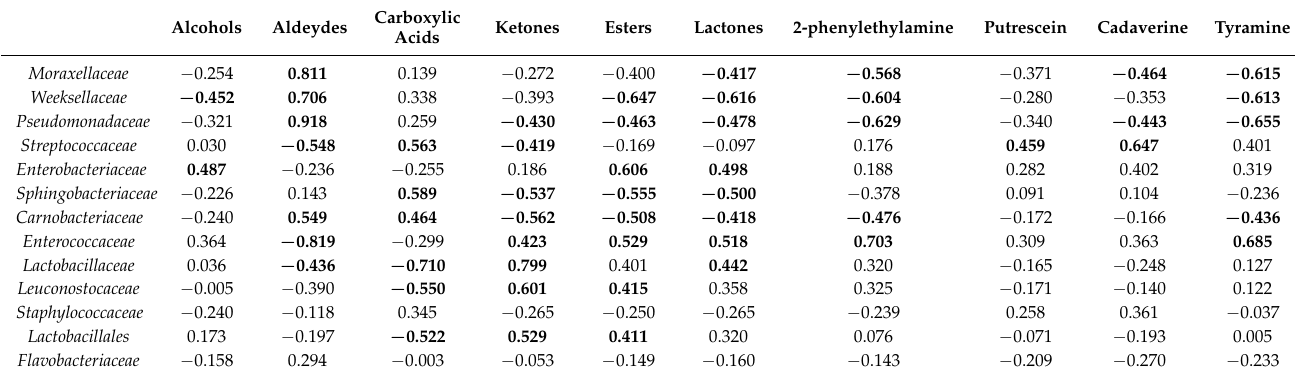
Table 3. Pearson’s correlations values between bacteria families and volatile organic compounds and biogenic